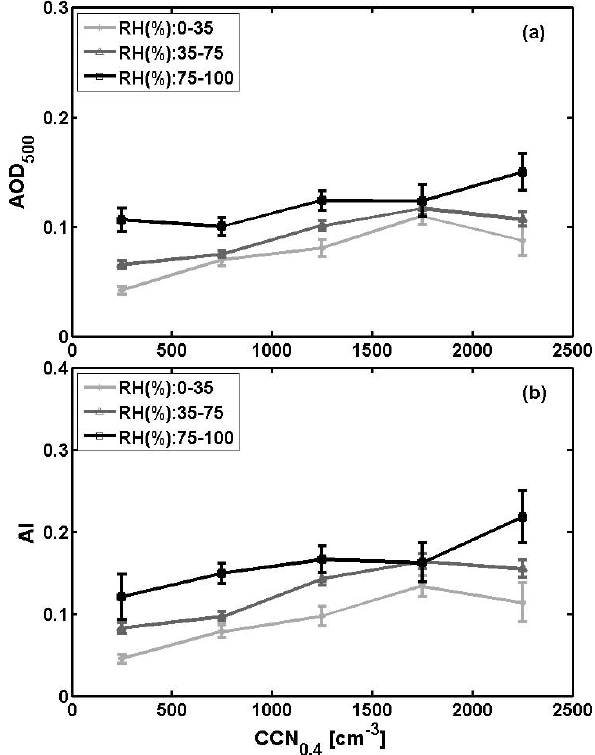
Fig. 3. (a) AOD at 500nm and (b) AI as a function of CCN 0 . 4 concentration for different ranges of ambient RH. Data are from the SGP